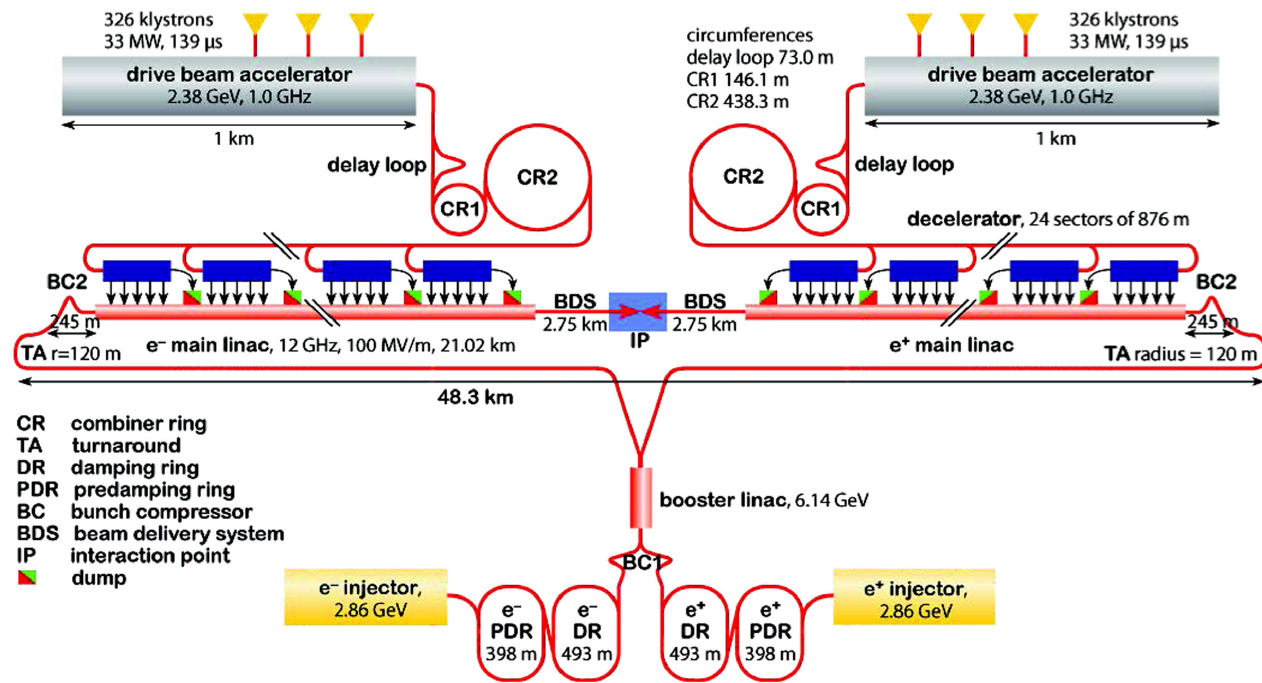
1. Layout of the Compact Linear Collider at 3 TeV [1] showing the combiner rings (CR) of the drive beams, the bunch compressor (BC), predamping and damping rings (PDR and DR, respectively) as well as turn/around loops (TA) and beam delivery system (BDS) of the main